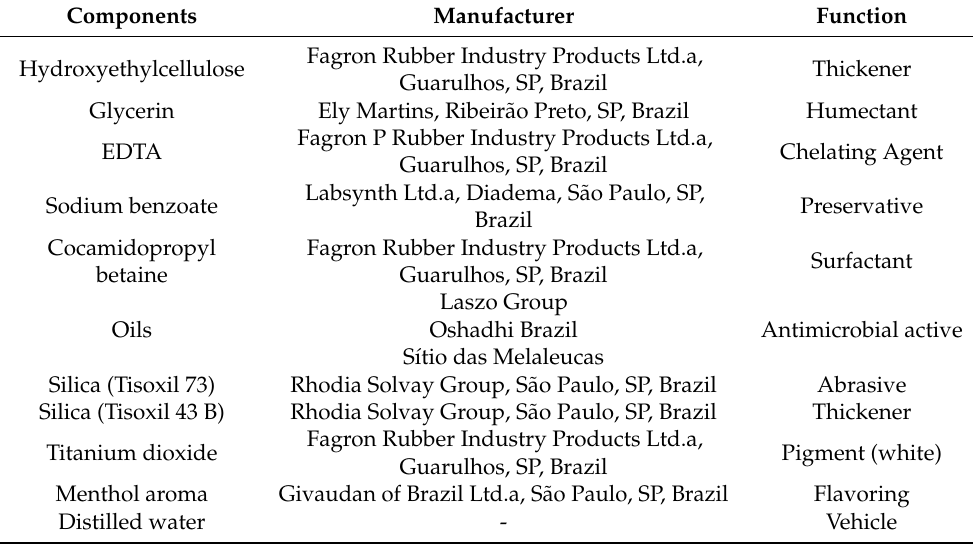
Table 7. Basic composition of experimental